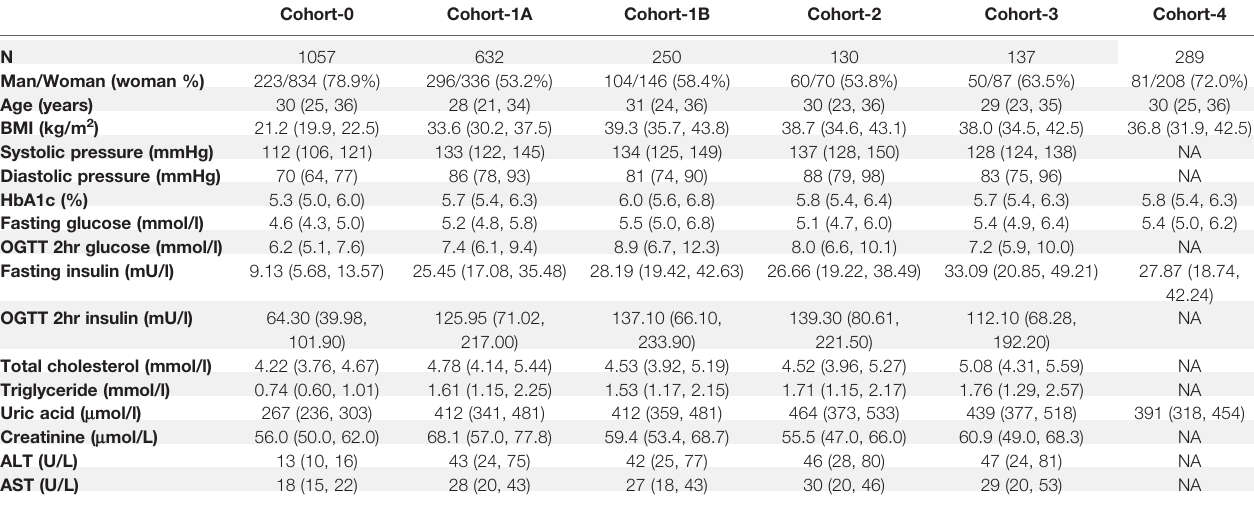
TABLE 1 | Key characteristics of patients in each